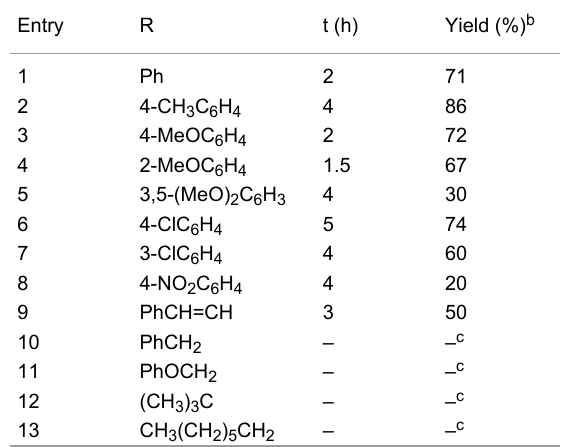
Table 2: Scope of the synthesis of N , N ′-methylenebisamide using CC-activated DMSO a